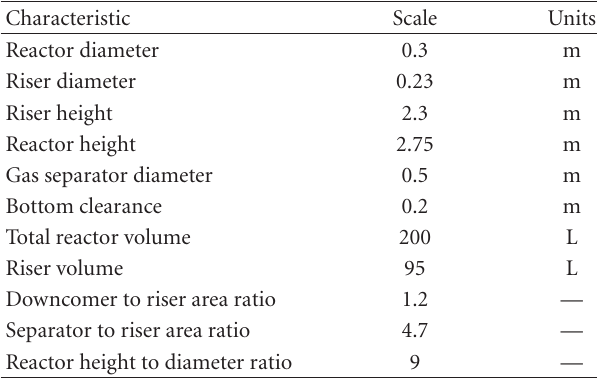
Table 1: Characteristics of the internal loop